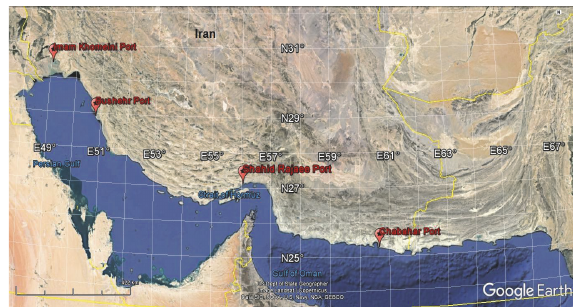
Figure 1: Location of main container Iranian ports